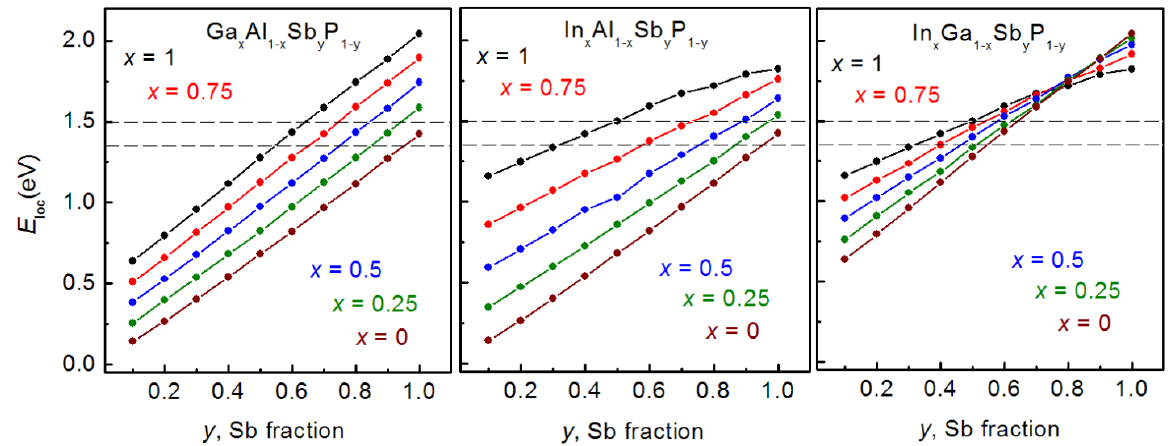
Figure 10. Calculated band alignment for the GaSb 0 . 65 P 0 . 35 /AlP SAQD.